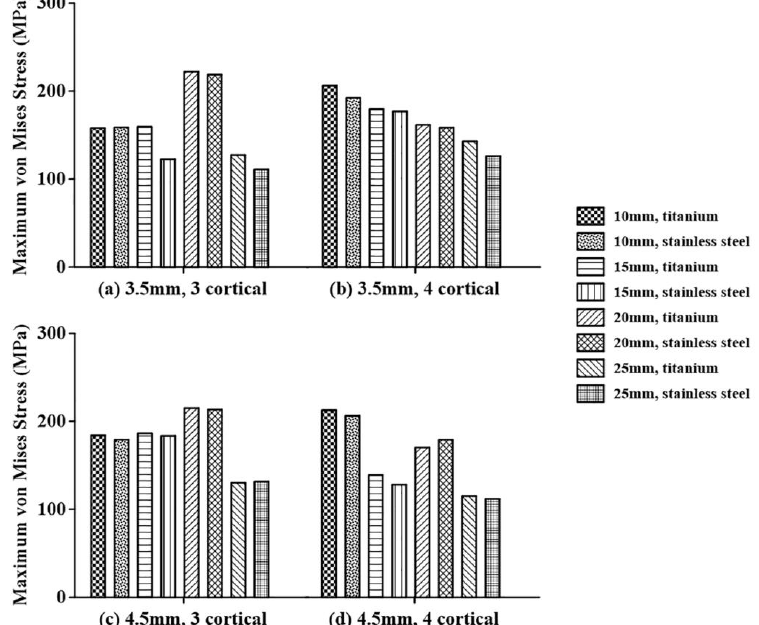
Figure 9. Analysis of the maximum von Mises stresses of the adjacent bone in terms of the screw material for screws with diameters of: ( a ) 3.5 mm penetrating three cortical bones, ( b ) 3.5 mm penetrating four cortical bones, ( c ) 4.5 mm penetrating three cortical bones, and ( d ) 4.5 mm penetrating four cortical bones. Appl. Sci. 2020 , 3 , x FOR PEER REVIEW